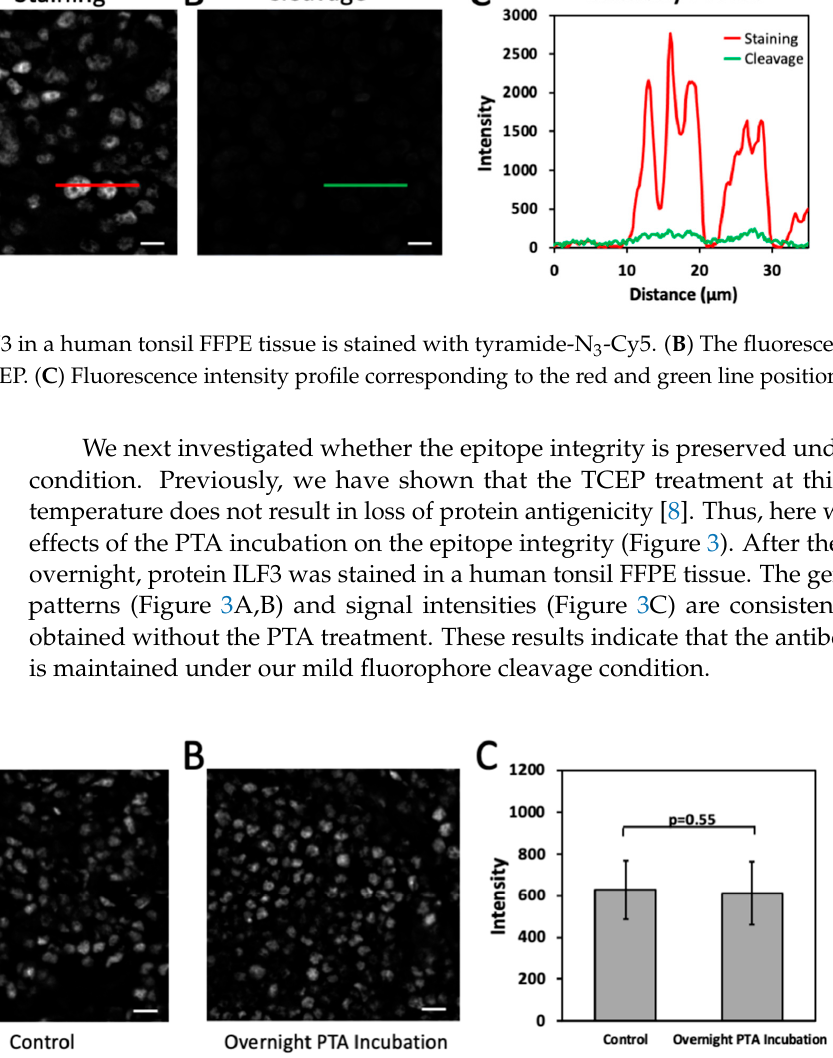
Figure 3. ( A ) Protein ILF3 in in a human tonsil FFPE tissue is directly stained with tyramide-N 3 -Cy5. ( B ) After the overnight PTA incubation, Protein ILF3 in in a human tonsil FFPE tissue is stained with tyramide-N 3 -Cy5. ( C ) Fluorescence intensity of ILF3 staining in ( A , B ) (n = 30 positions). Error bars generated using standard error of the mean. Scale bars, 10 μ m.